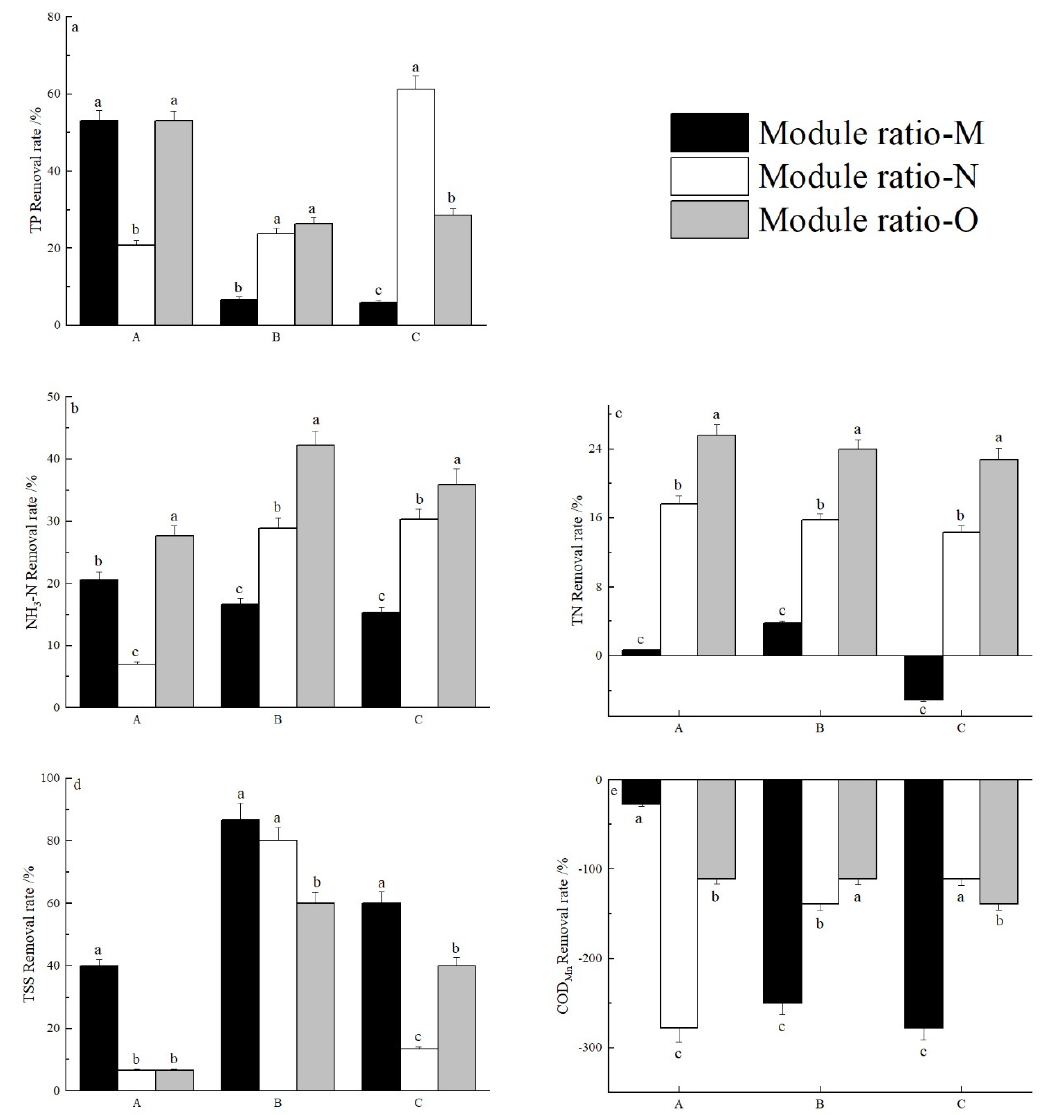
Figure 5. Removal rate of aquaculture wastewater from wastewater treatment device under three kinds of units. ( a ) TP, ( b ) NH 3 -N, ( c ) TN, ( d ) TSS, ( e ) COD Mn .